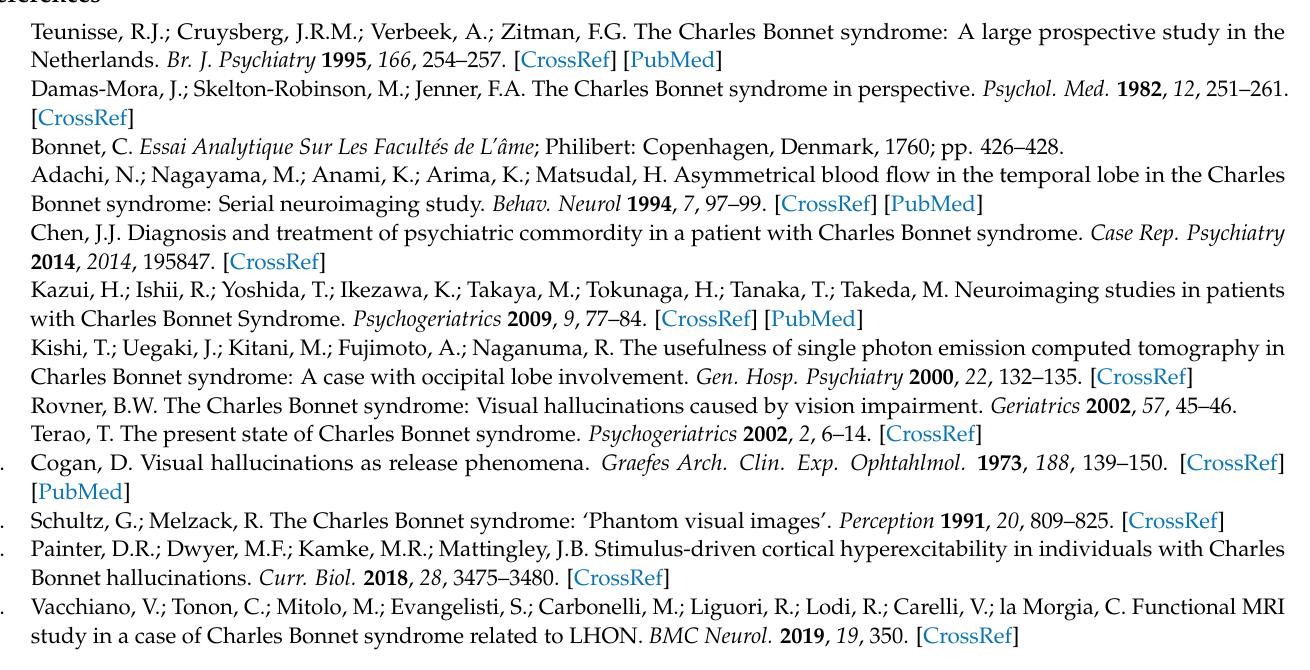
connectivity analysis, Figure S3: Graph theoretical metrics: Delta, Figure S4: Graph theoretical metrics: Theta, Figure S5: Graph theoretical metrics: Alpha, Figure S6: Statistics of the Lempel–Ziv complexity, Table S1: Delta networks, Table S2: Theta networks, Table S3: Alpha